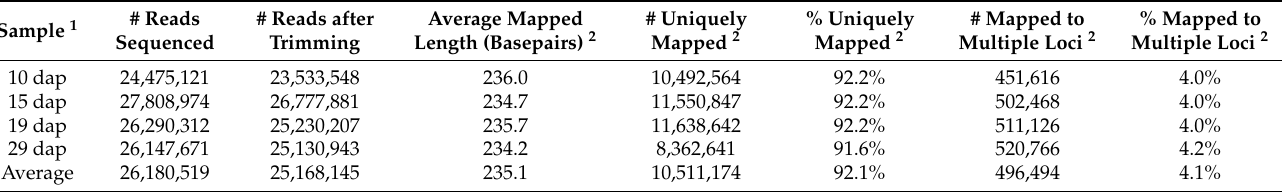
Table 1. Mapping of Illumina Paired-End